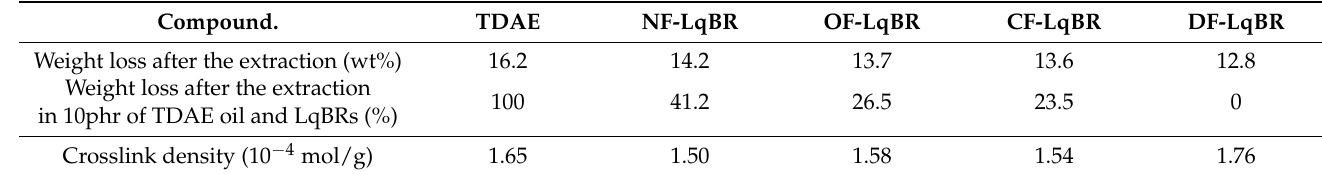
Figure 7. ( a ) Weight loss after extraction and ( b ) crosslink density of the vulcanizates. Table 8. Weight loss of the vulcanizates after extraction and crosslink density.